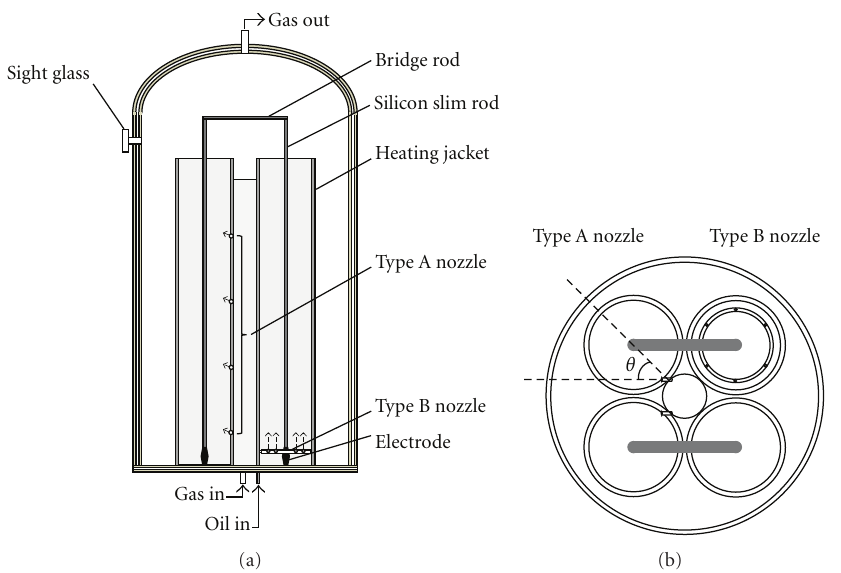
Figure 1: Schematic diagram of MS-Siemens